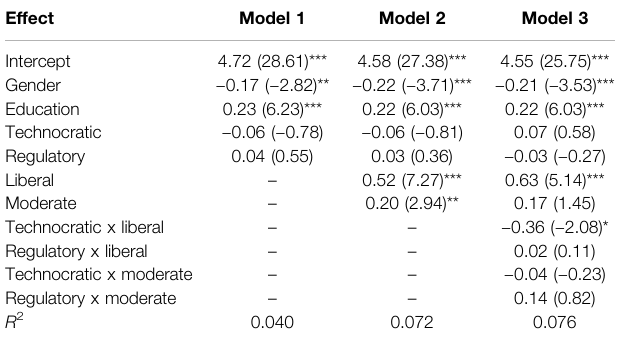
TABLE 3 | Multiple regression modeling the effects of political ideology and treatment group on perceived study validity of the Nature Science article.